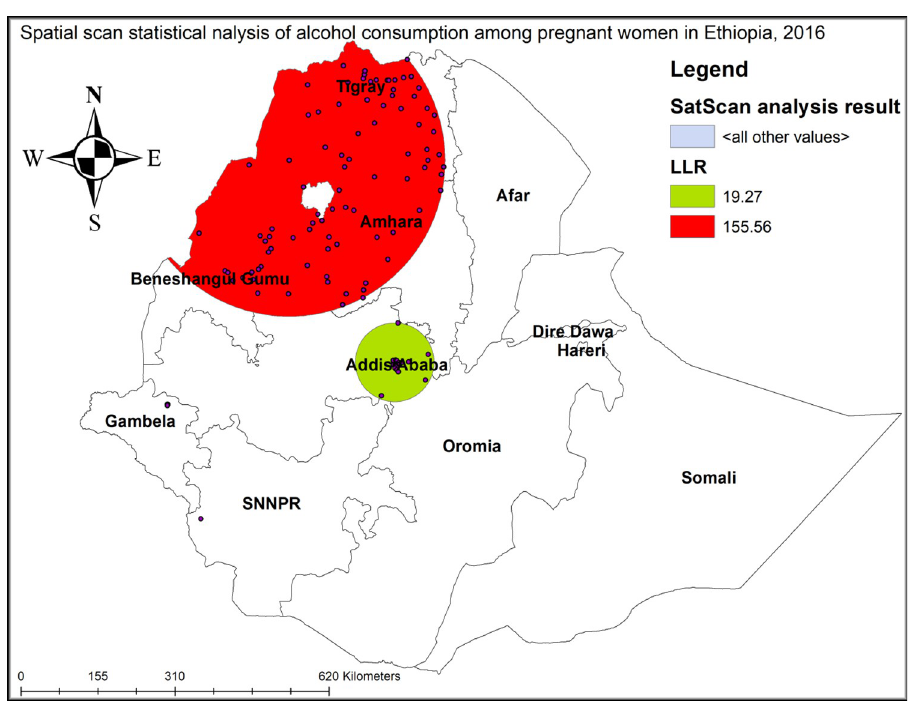
Fig 6. SaTScan analysis of hotspot clusters of alcohol consumption among pregnant women in Ethiopia, 2016.